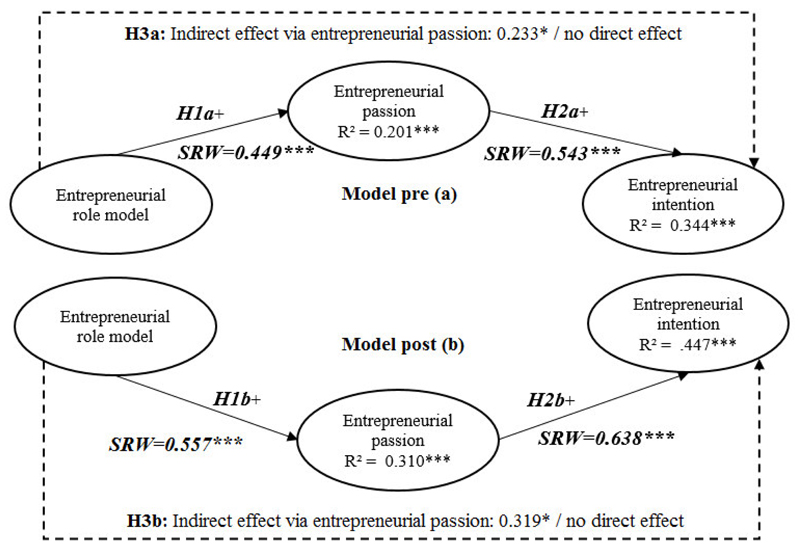
Sem Model Results: Standardized Regression Weights for the Hypotheses (N = 426)Notes: Standardized Regression Weights (SRW), 90% confidence interval.Significance codes: ***=p<.01, **=p<.05, *=p<.1. The goodness of fit indices for model pre (a): χ2= 1355.28; χ2/df = 2.818; GFI = .835; CFI = .916; TLI = .916; IFI = .908; RMSEA = .065. Goodness of fit indices for model post (b): χ2= 1332.71; χ2/df = 2.782; GFI = .845; CFI = .927; TLI = .920; IFI = .928; RMSEA = .065.